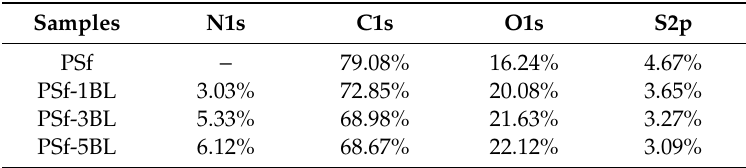
Figure 3. XPS spectra of ( a ) PSf, ( b ) PSf-1BL, ( c ) PSf-3BL, and ( d ) PSf-5BL membranes. Table 1. Surface composition of PSf, PSf-1BL, PSf-3BL, and PSf-5BL membranes from XPS spectra (in atomic percent).